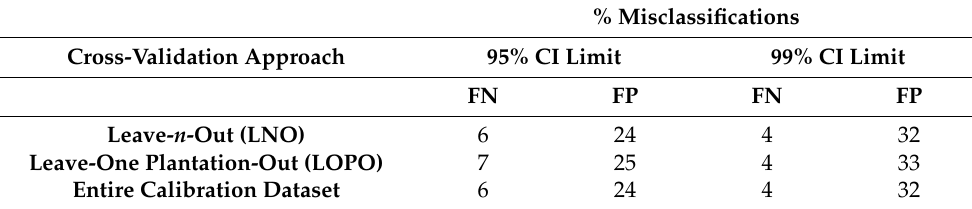
Table 3. The total FN and FP error rates of the CV approaches. The entire calibration dataset consisted of 426 intra-plantation r-values with 4230 inter-plantation correlation coefficients. % Misclassifications Cross-Validation